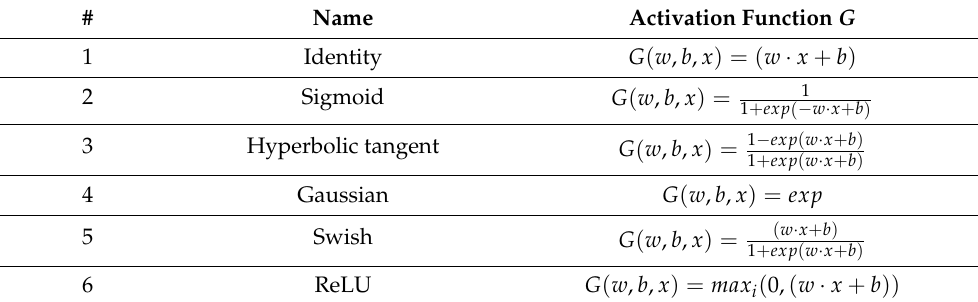
Table 3. Activation functions used in